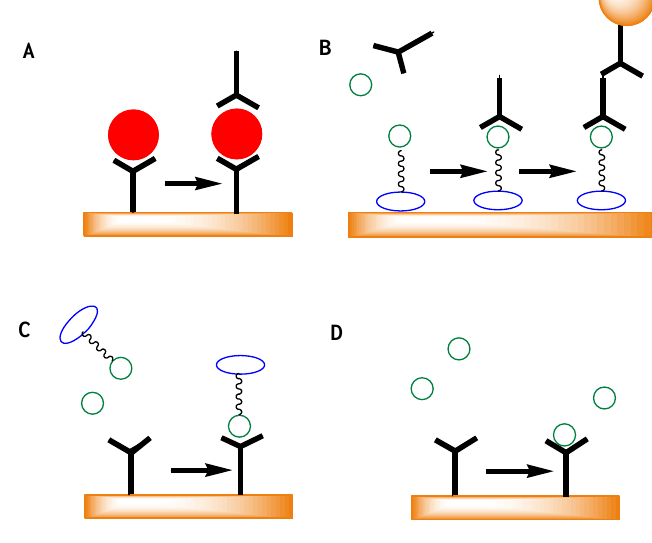
Figure 2. A schematic of some typical SPR immunosensor formats. A. Sandwich immunoassay for large molecules. B. Protein conjugate immobilized indirect inhibition immunoassay (can also link via self-assembled monolayers (SAMs) or carboxymethyl dextran polymers) with optional secondary antibody-gold nanoparticle labeling in a